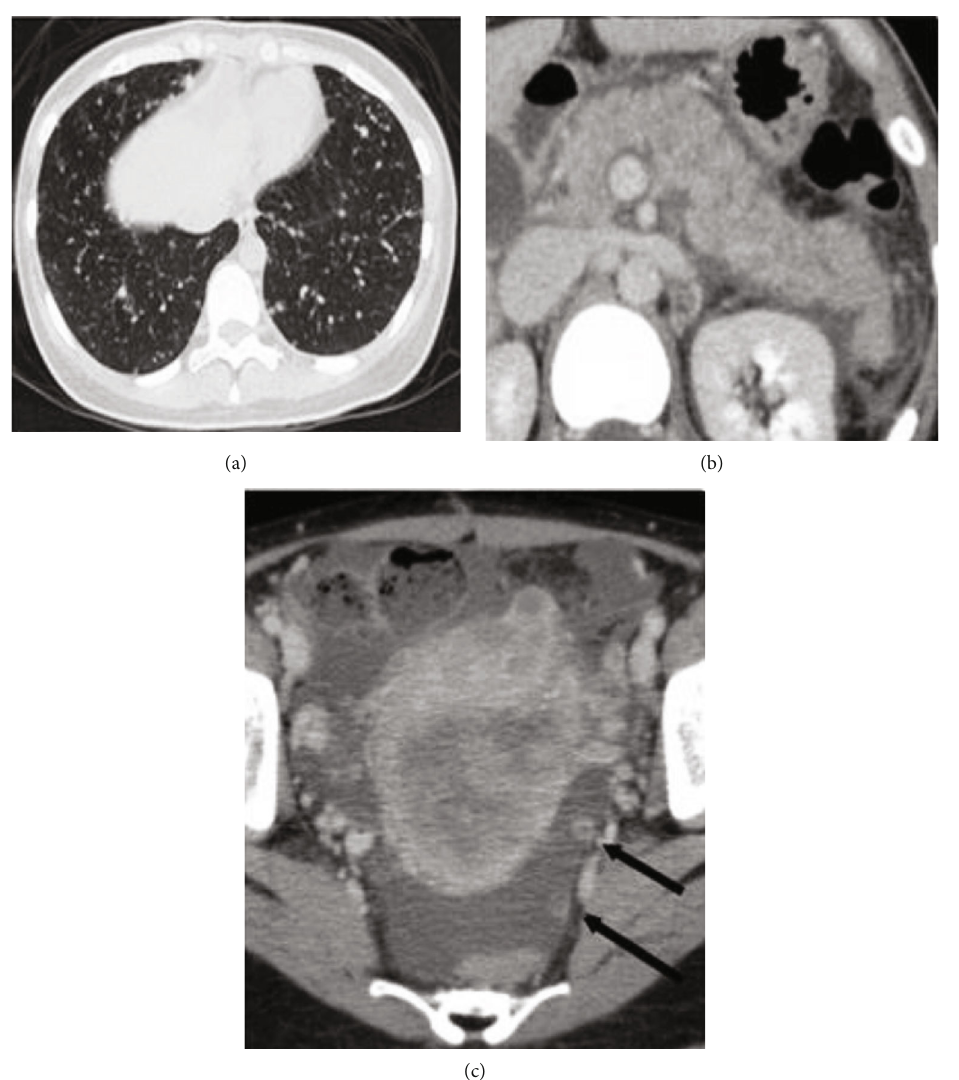
Figure 2: Contrast-enhanced computed tomography. (a) Numerous nodules were visible in bilateral lungs. (b) The pancreas is edematous and surrounded by e ff usion. (c) The uterus was enlarged, and the myometrium was irregularly stained. On the pelvic peritoneum, nodules were found